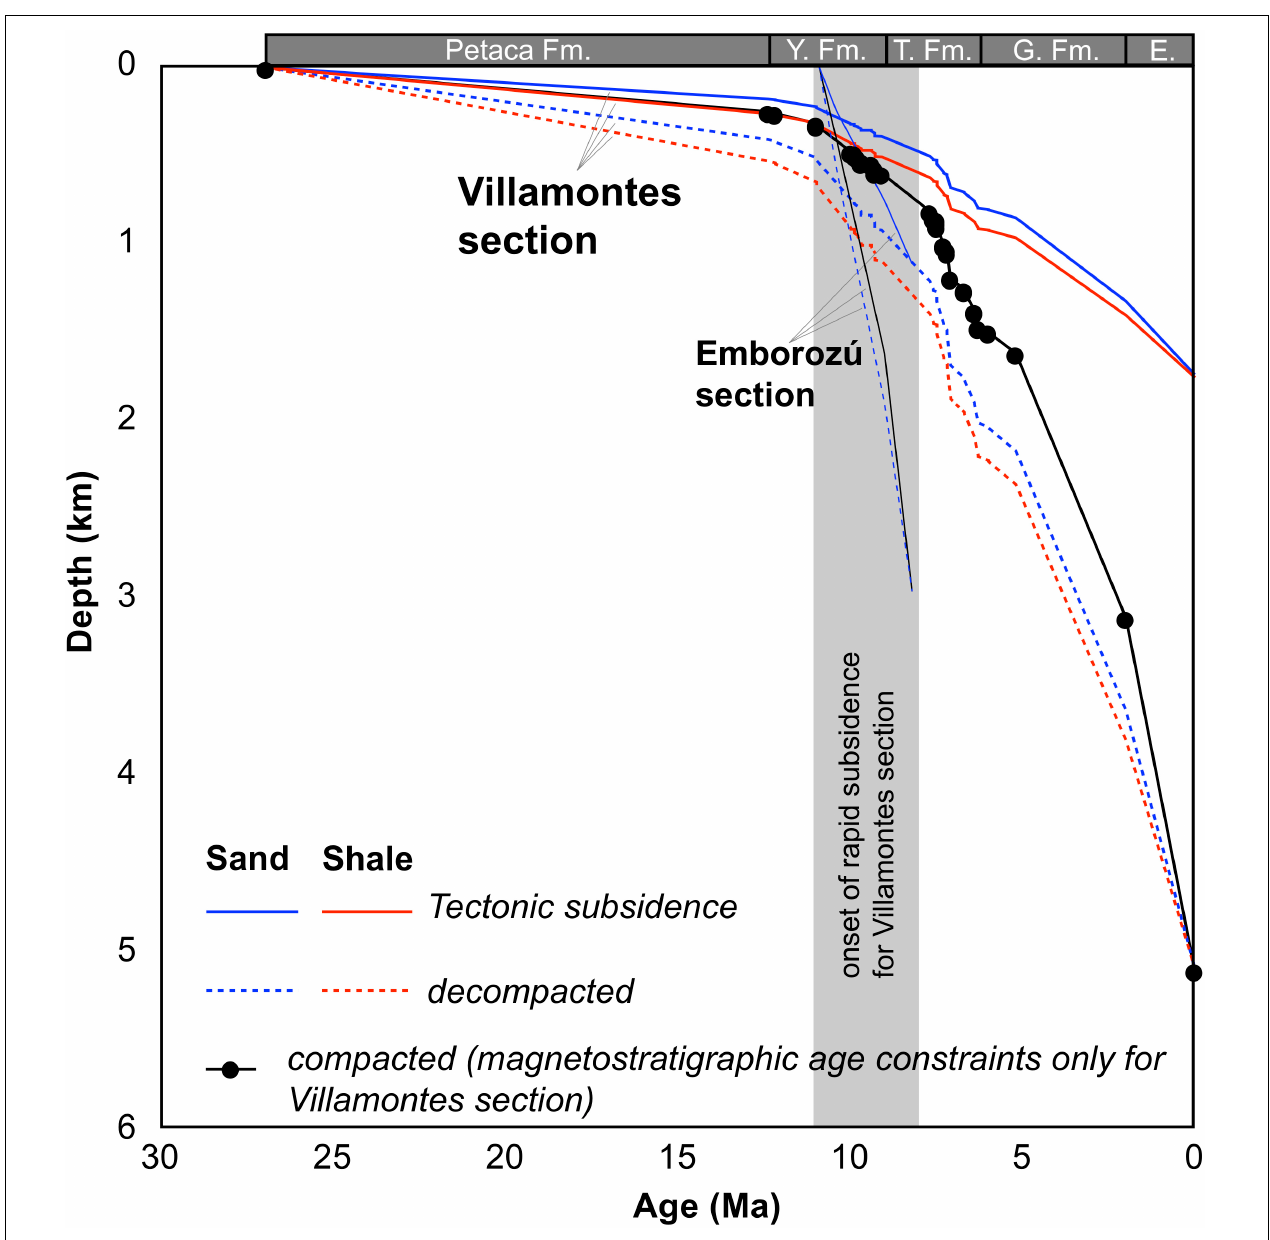
FIGURE 5 | Backstripping results for the Villamontes and Emborozú sections. Villamontes succession combines magnetostratigraphic results for 1,370 m of section spanning ca. 12–5 Ma depositional age, dominantly the Yecua (Y. Fm.) and Tariquia Formations (T. Fm.), and adds the general age and maximum thickness estimates for the underlying Petaca Formation, and overlying Guandacay (G. Fm.) and Emborozú Formations (E.) (from Uba et al., 2007). The Emborozú site has limited chronostratigraphic constraints, and no attempt was made to include the under- or overlying strata. At the Villamontes site, the impact of pure sandstone and pure shale lithologies on backstripping results was assessed, with minor differences in total tectonic subsidence between the lithologies, and recognizing that the Villamontes section is not a single lithology. For the Emborozú site, only sandstone lithology was used. Note that rapid sediment accumulation was ongoing at ca. 11 Ma, and similar rates of sediment accumulation are not observed at the Villamontes succession until ca. 8 Ma and later.